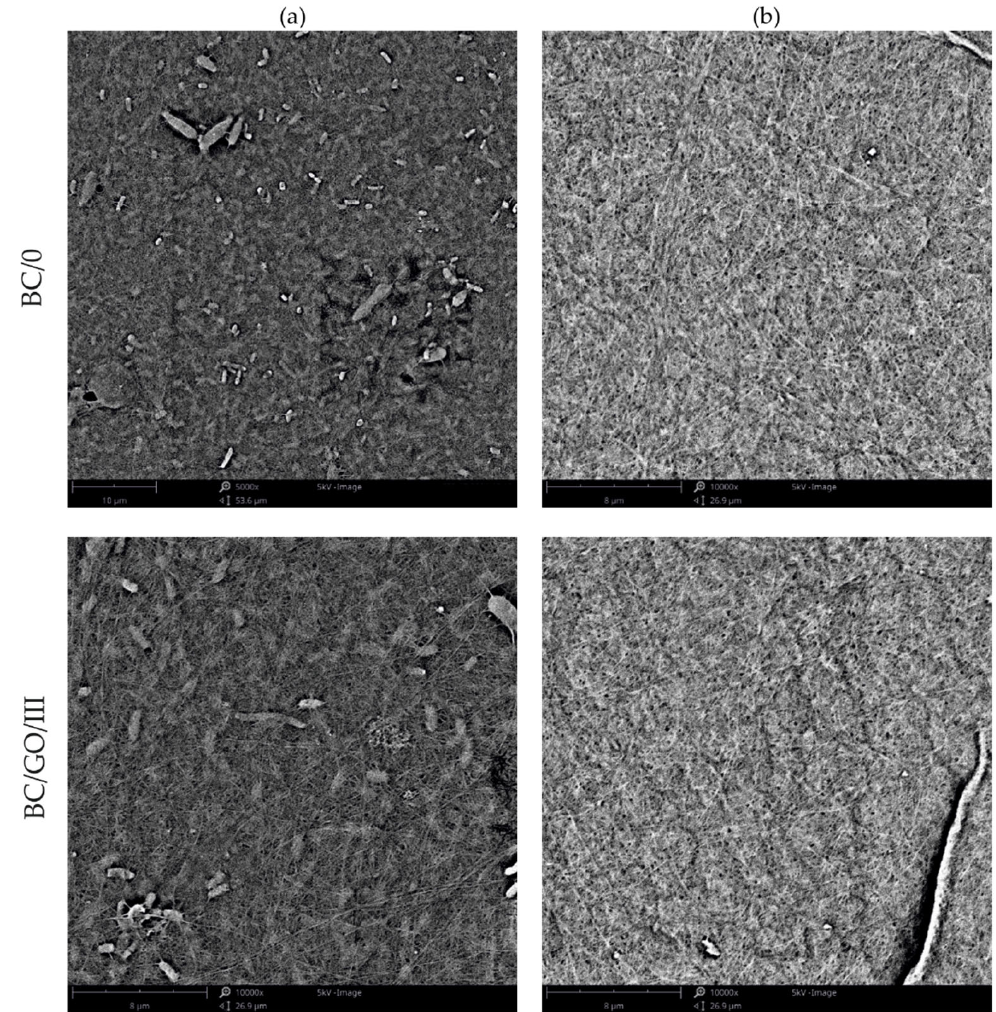
Figure 2. SEM photo of the membrane made from pure BC/0 and sample BC/GO/III: ( a ) after the synthesis process—with visible bacterial cells; ( b ) after KOH purification process.